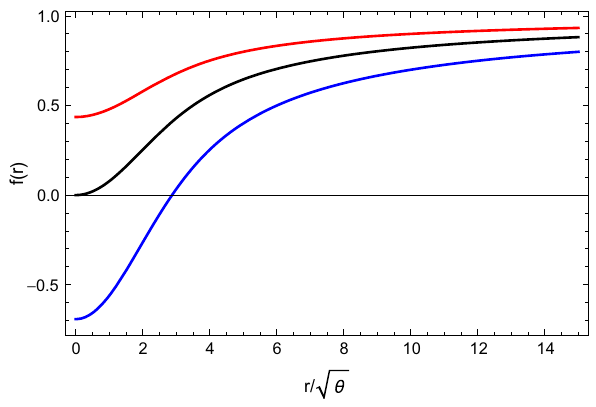
Fig. 1 f ( r ) as a function of r . The curves from top to bottom corre- spond to the values of M / G =